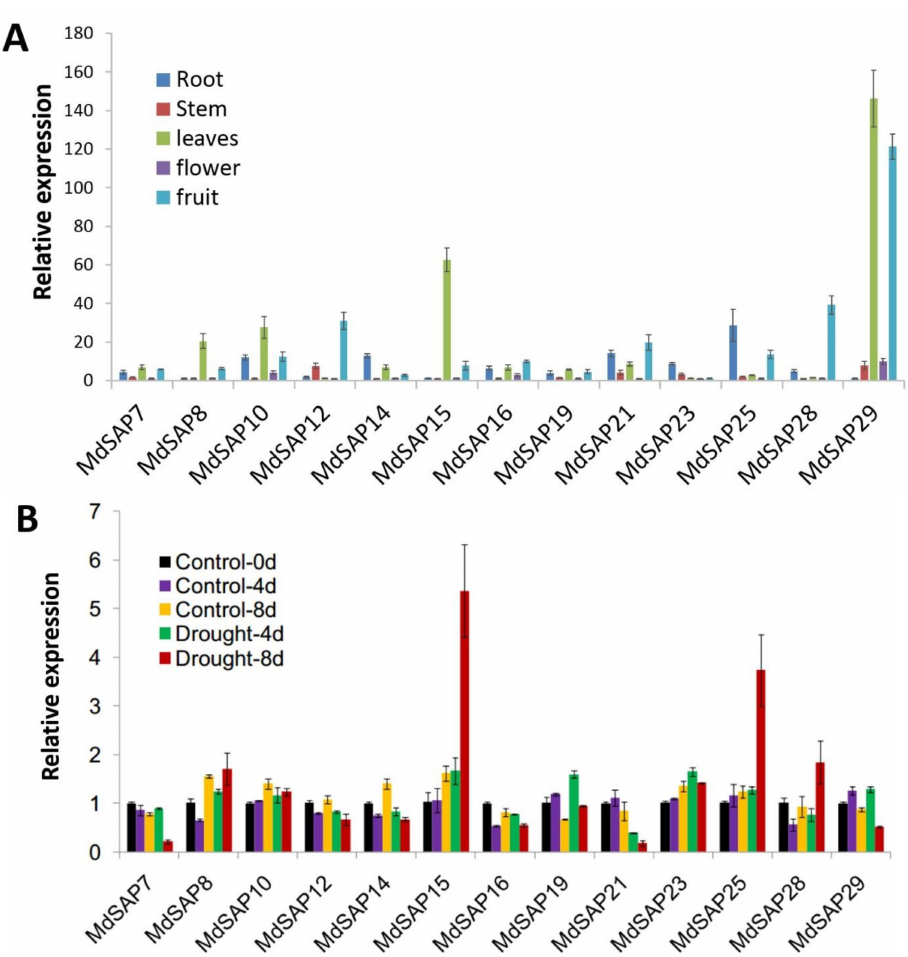
Figure 6. Tissue-specific expression and drought response of 13 MdSAP genes. ( A ) Expression patterns of 13 MdSAP genes in apple tissues. ( B ) Expression patterns of 13 MdSAP genes in response to drought stress, i.e., normally scheduled irrigation withheld for 0, 4, or 8 days. Three independent replicates were used for calculations. Error bars indicate standard